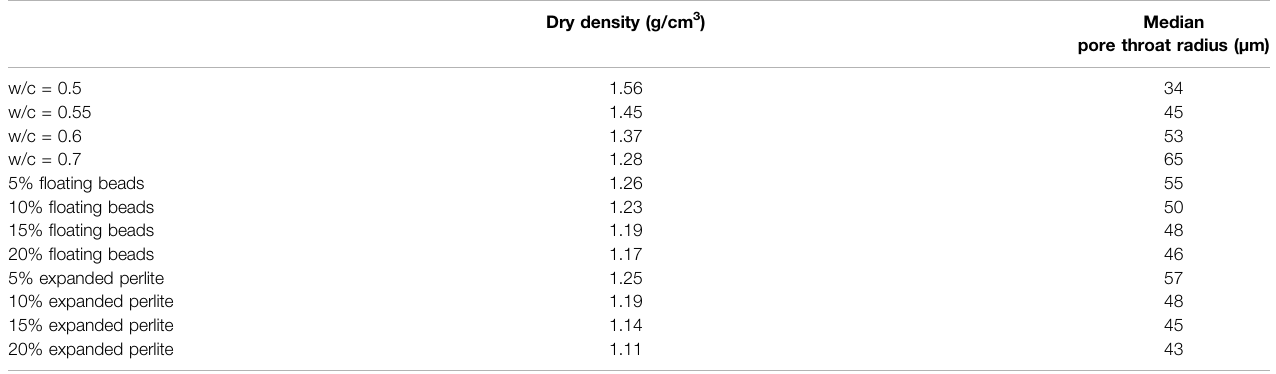
TABLE 5 | Dry density and median pore throat radius of cement.